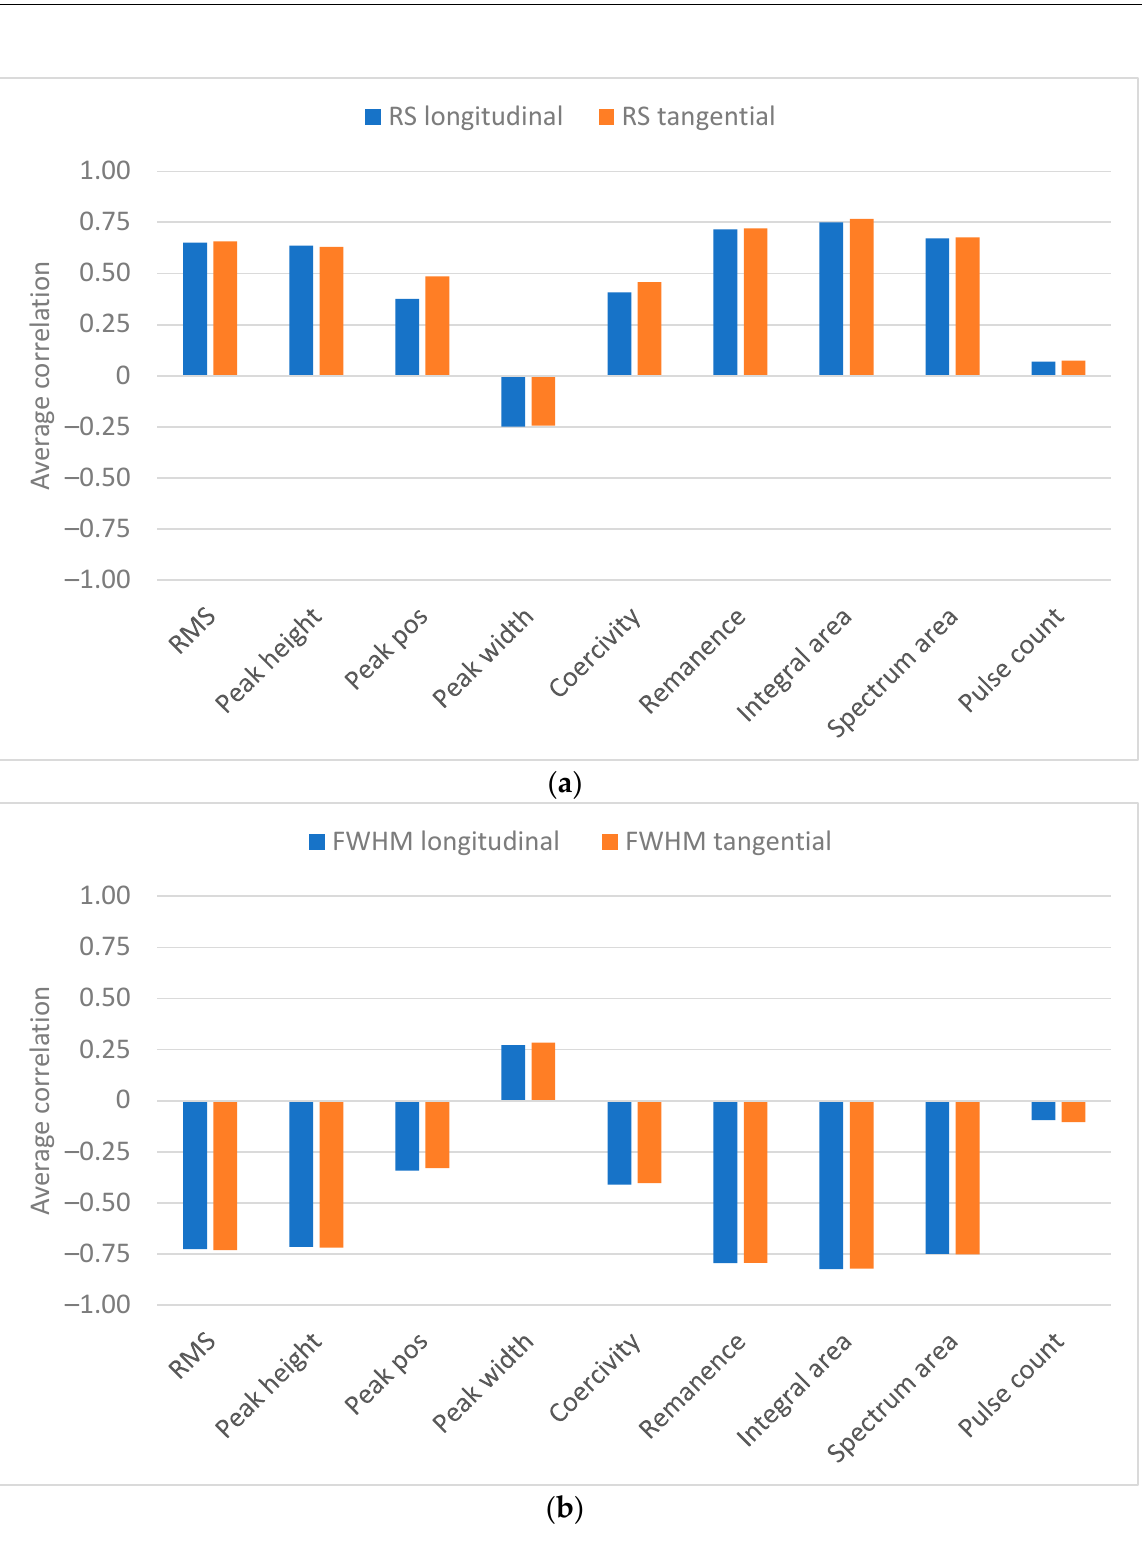
Figure 6. ( a ) Average absolute correlation between BN features and RS. ( b ) Average absolute correlation between BN features and XRD FWHM.